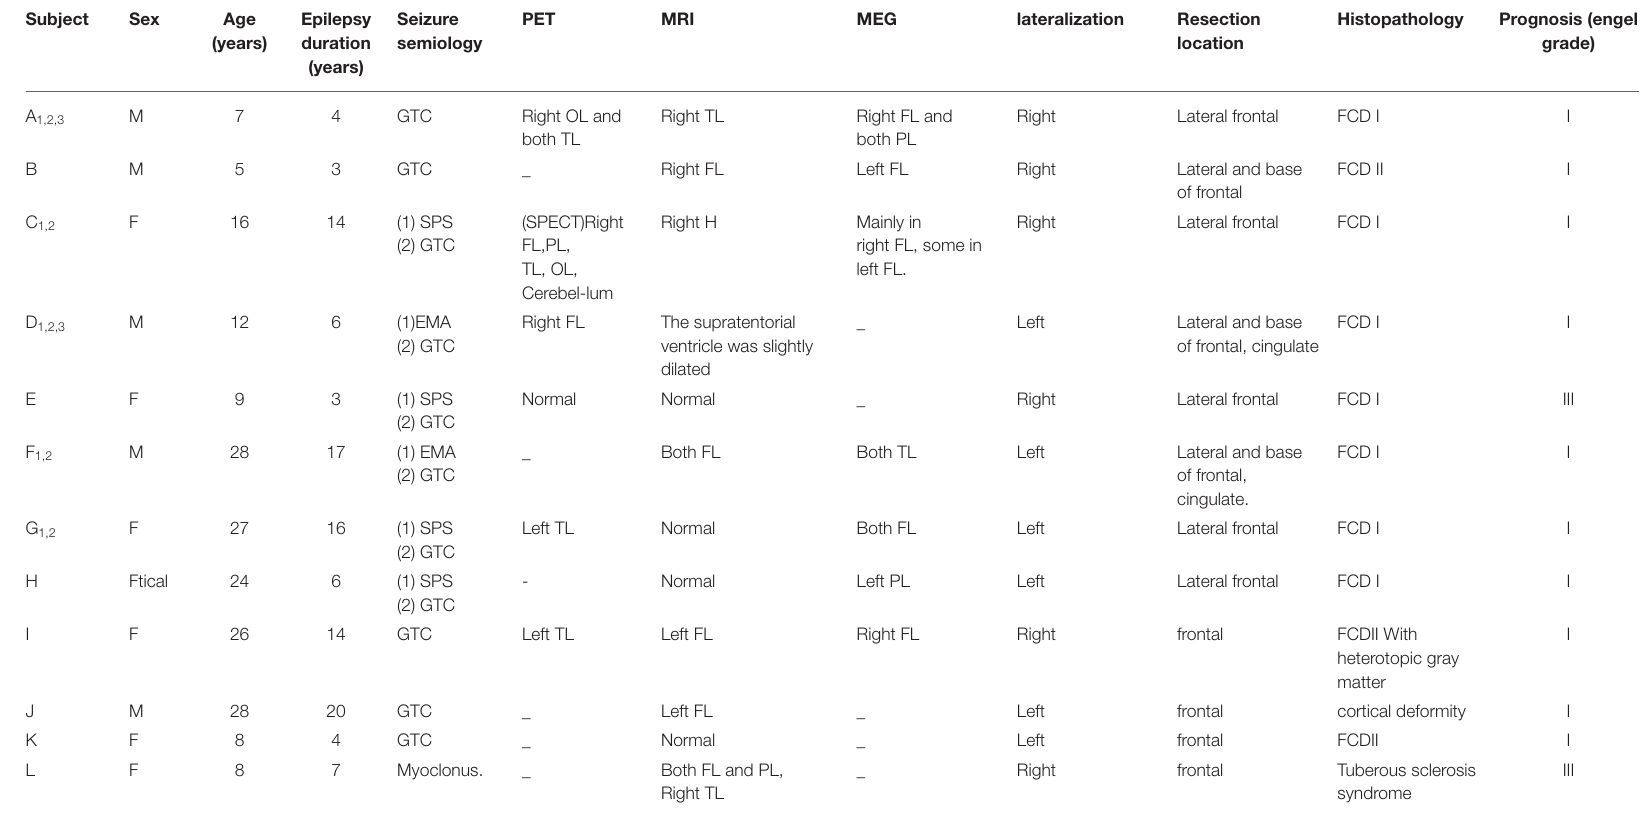
Twelve patients are marked by English letters. The Arabic numerals in the right of English letter indicate the number of seizure. GTC, secondarily generalized tonic-clonic seizures; EMA, excessive movement automatism; SPS, simple partial seizures; FCD, focal cortical dysplasia; FL, frontal lobe; PL, parietal lobe; TL, temporal lobe; OL, occipital lobe; H,